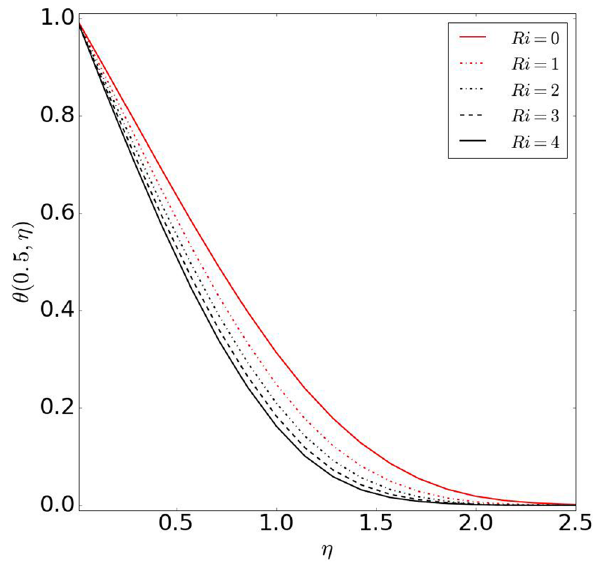
Fig. 15 Temperature Profile with different R i with fixed 𝜉 = 0.5 and 𝜙 = 0.05 for Al 2 O 3 -water nanofluids